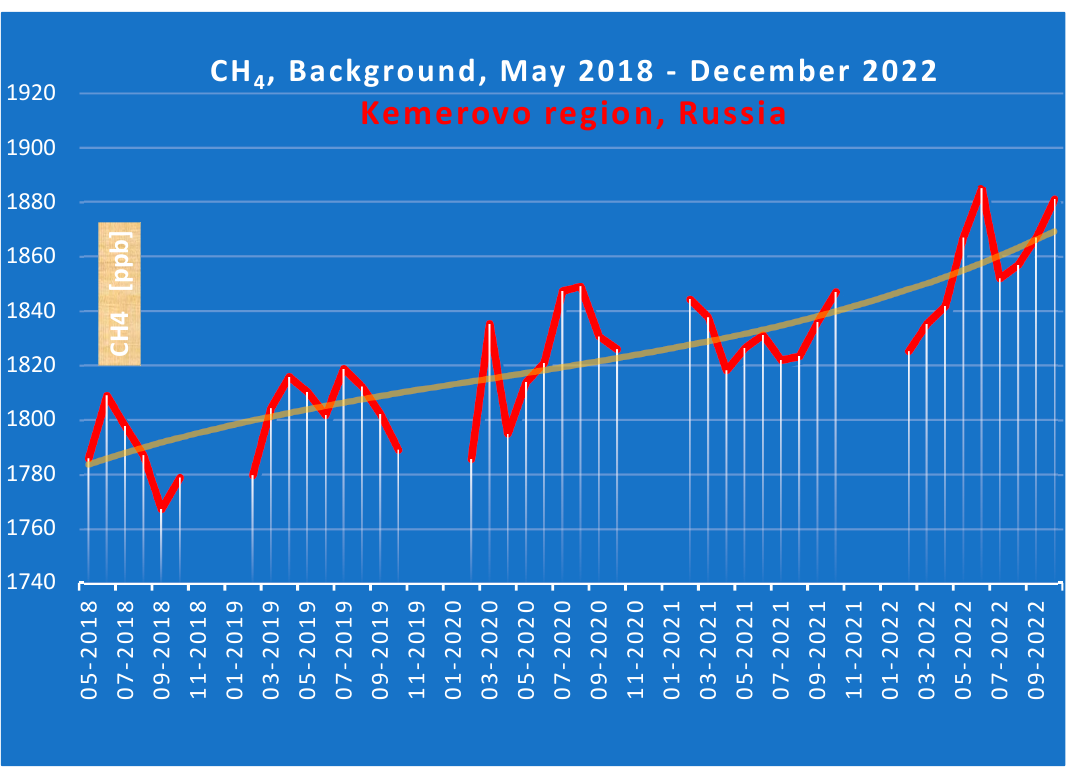
Figure 4. Background concentrations of methane in the atmosphere over the Kemerovo region for the period May 2018–December 2022. Data used–Sentinel-5P.